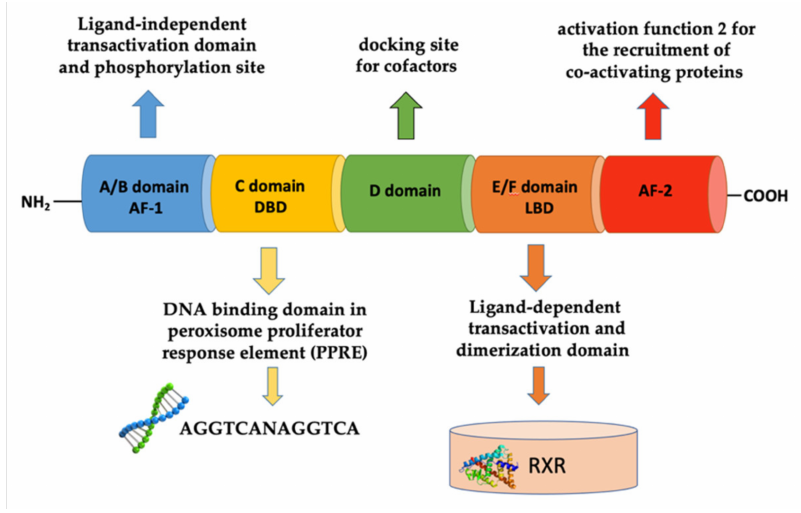
Figure 1. Schematic representation of the structure of PPAR receptor. PPARs Isoforms: Tissue Distribution and Biological